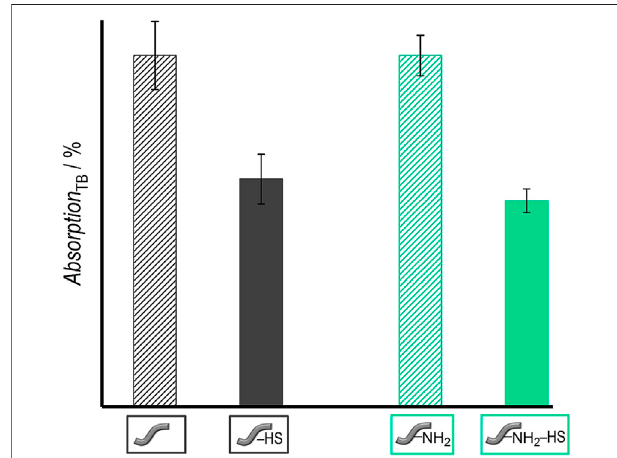
FIGURE 6 | Results of TB assay: Absorption of TB solutions after contact with different types of fi bers: Unmodi fi ed fi bers without HS (grey stripes)/with HS (grey) as well as amino-modi fi ed fi bers without HS (green stripes)/with HS (green) (right). Values are given as mean ± standard error of the mean ( N (cid:1) 3).